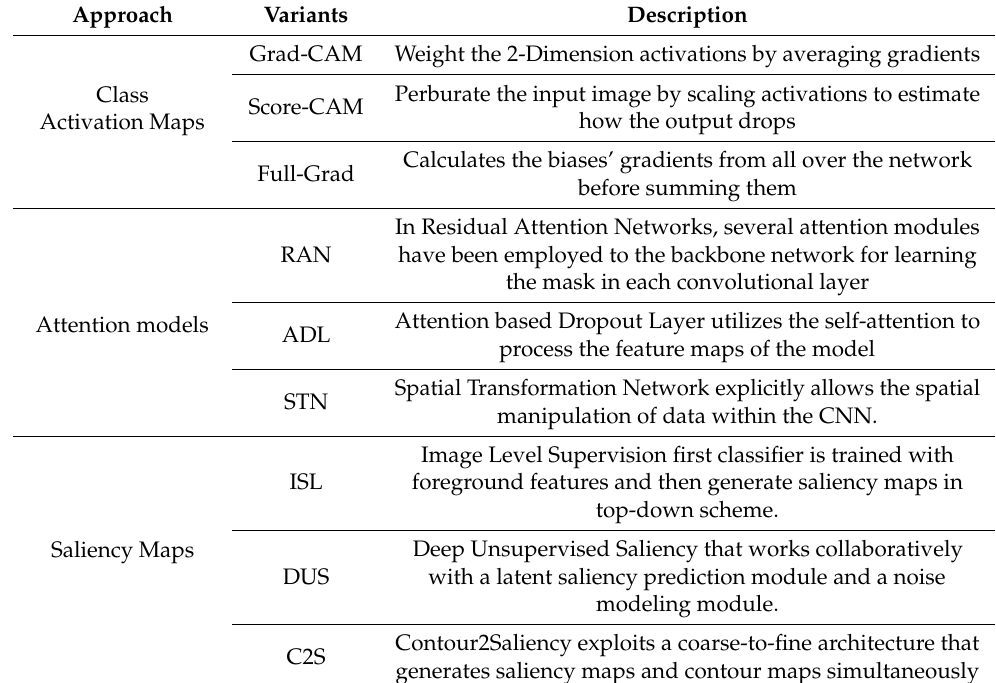
Table 4. Summary of Weak Supervised based Deep Learning approaches for object